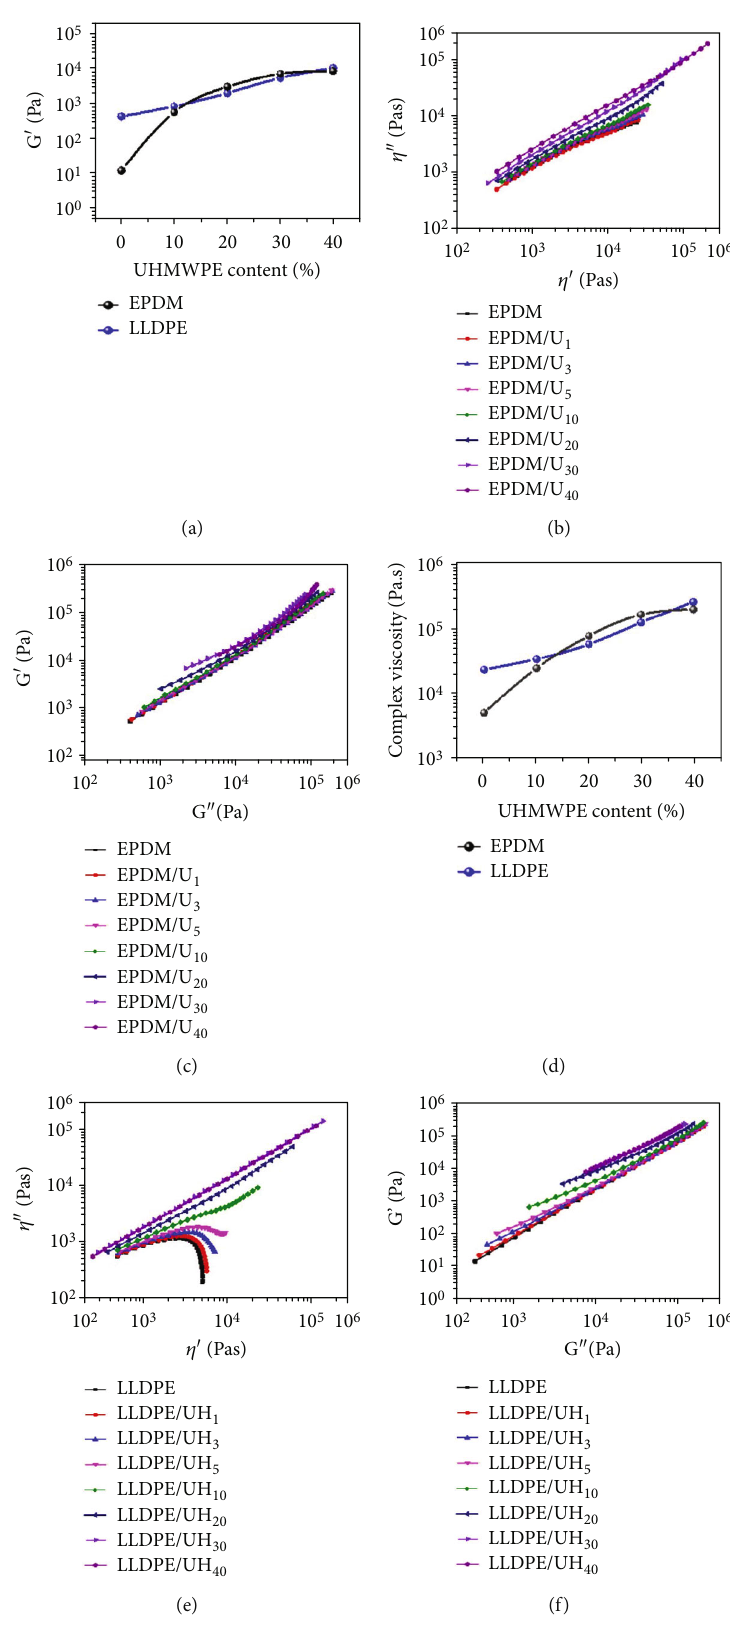
Figure 6: (a, d) Variation of storage modulus and complex viscosity at 0.01 Hz versus UHMWPE content at 190 ° C for EPDM/U and LLDPE/U. (b, e) Cole-Cole curves for EPDM/U and LLDPE/U. (c, f) Han curves for EPDM/U and